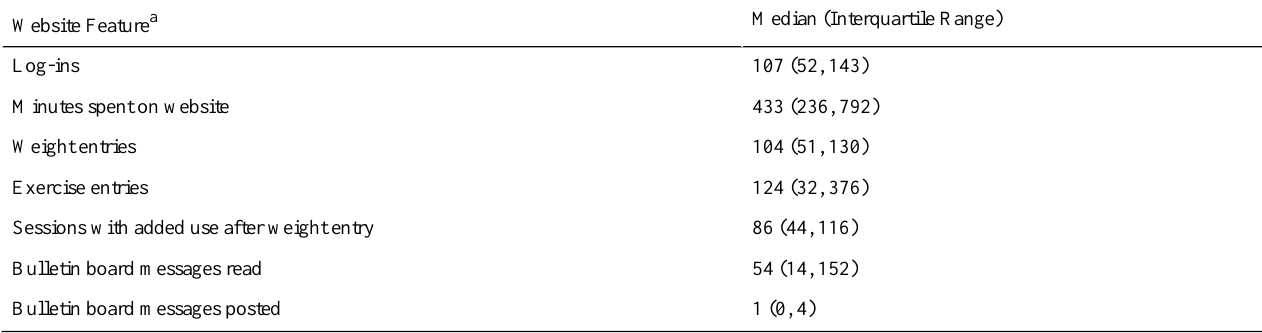
Table 2. Overall use of specific website features over the 28 study months (N =